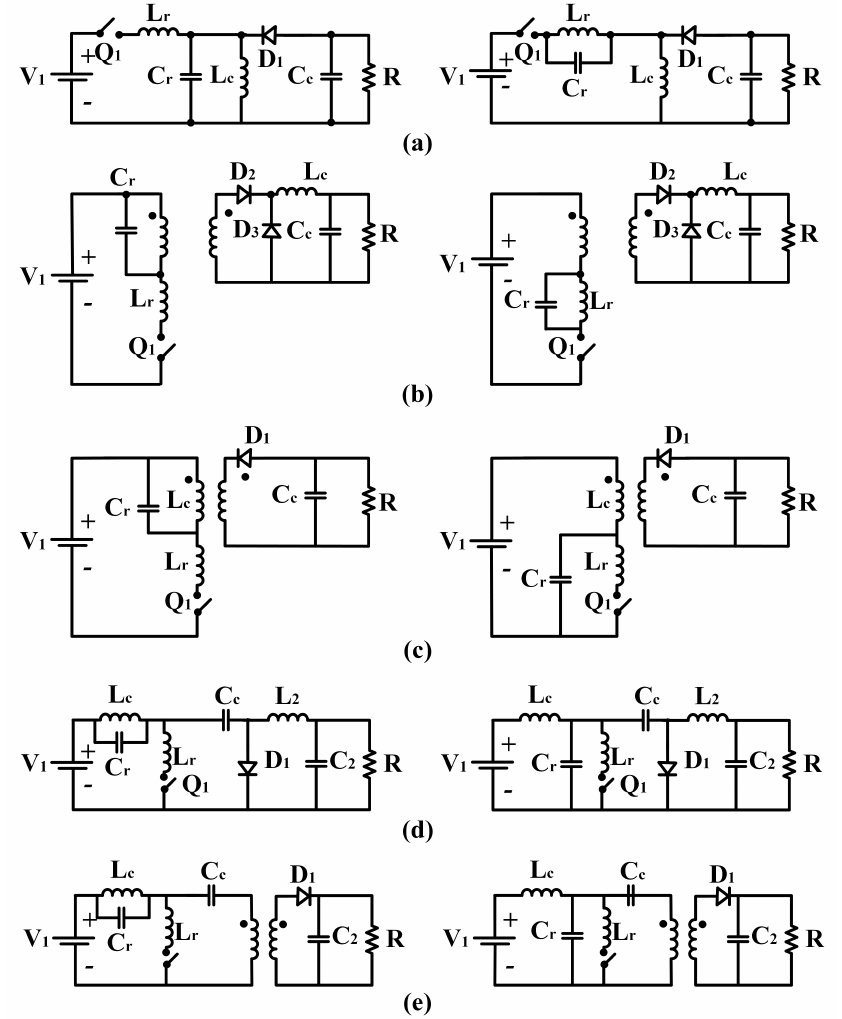
Figure 7. Quasi-resonant topologies: ( a ) buck–boost, ( b ) forward, ( c ) flyback, ( d ) ´Cuk, and ( e )